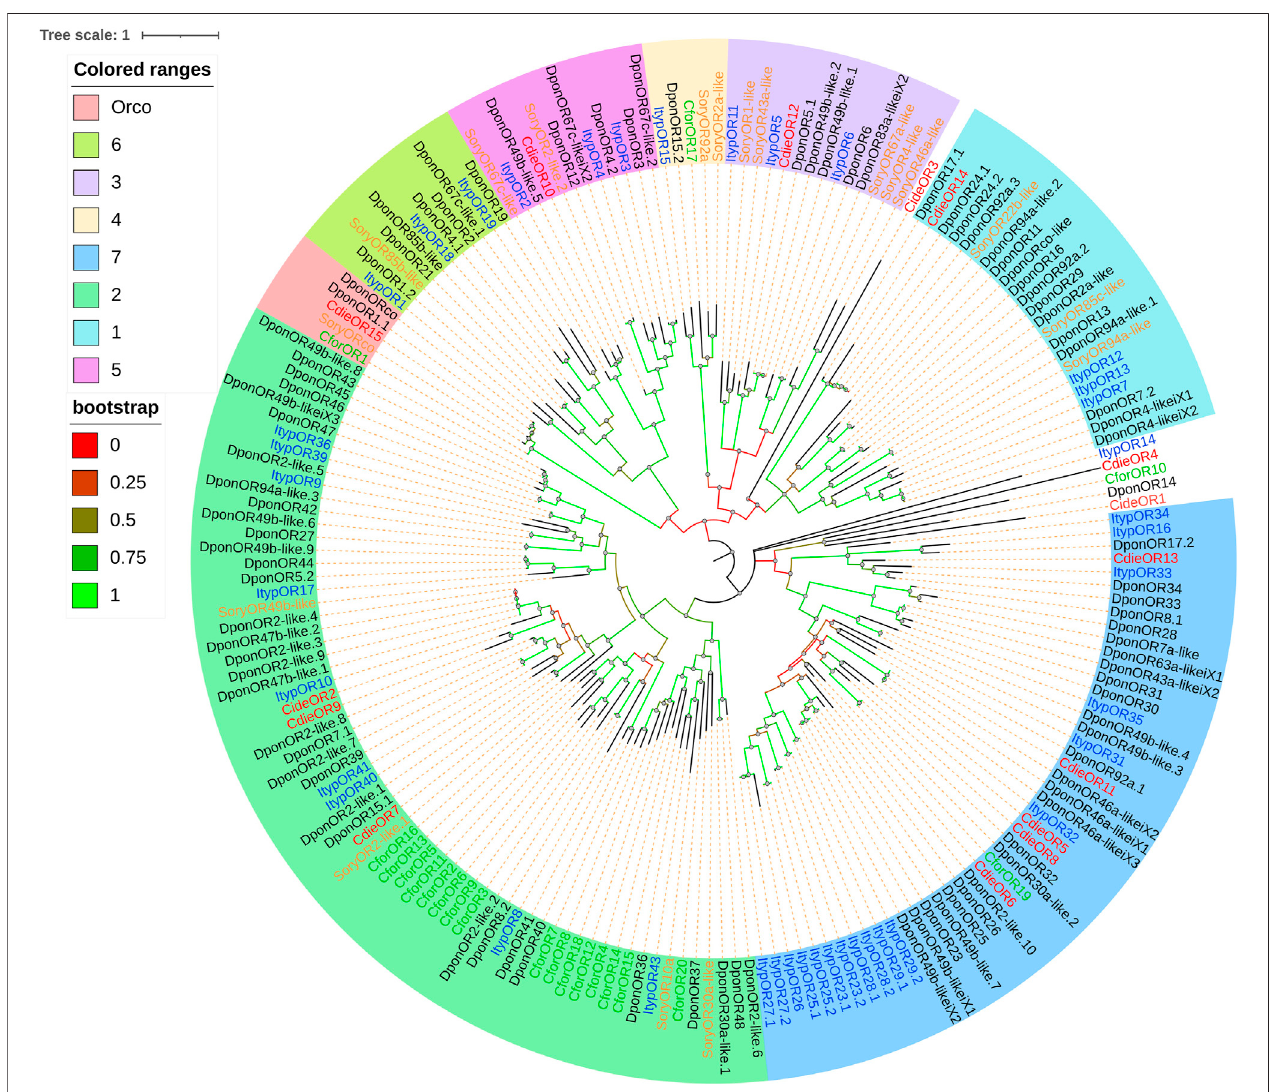
FIGURE 6 | Maximum likelihood phylogenetic tree of candidate ORs in C. dieckmanni (Cdie, red), Dendroctonus ponderosae (Dpon, black), Ips typographus (Ityp, blue), Cylas formicarius (Cfor, green), and Sitophilus oryzae (Sory, orange). The scale bar represents 1 amino acid substitution per site.